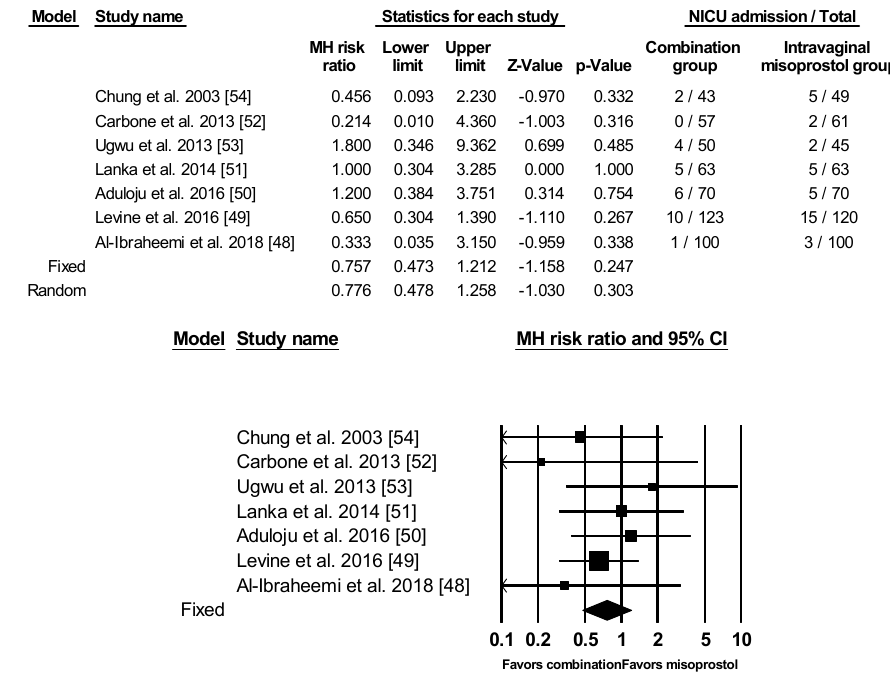
Figure 10. Comparison 9: Combination of intracervical Foley catheter and intravaginal misoprostol versus intravaginal misoprostol alone for cervical ripening, Outcome 9: neonatal intensive care unit (NICU) admission. Heterogeneity: Tau 2 = 0.000; χ 2 = 3.631 df = 6 ( p = 0.726); I 2 = 0.000%. Test for overall effect (fixed): Z = − 1.158 ( p = 0.247).